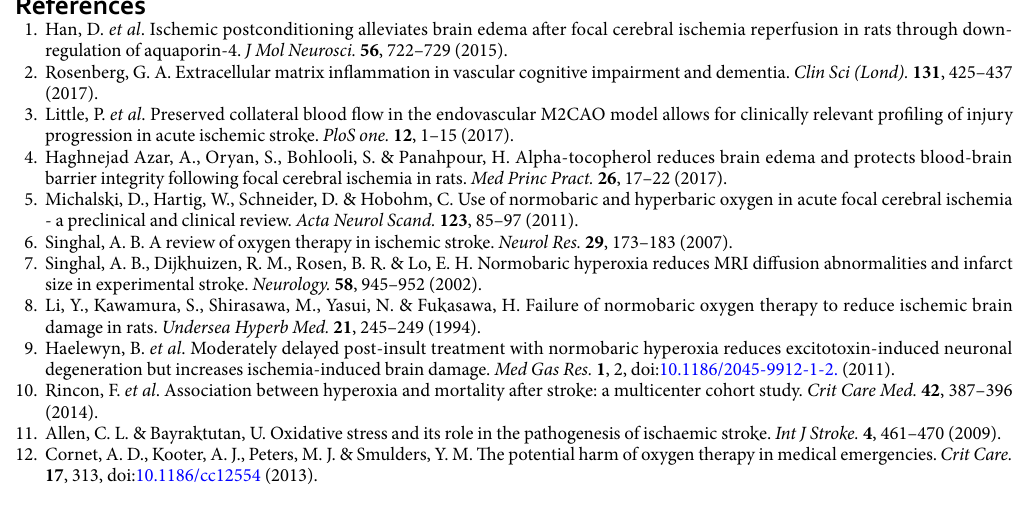
In conclusion, our findings showed that early NBO treatment did not reduce ischemic brain injuries and does not produce protective effects against vasogenic cerebral edema formation and BBB disruption following acute ischemic stroke. Reduction of brain tissue antioxidant power and increases in lipid peroxidation may be a possi- ble mechanism for early oxygen therapy failure. Further experimental studies are needed to clarify the beneficial effects and potential side effects of early oxygen therapy before clinical use.